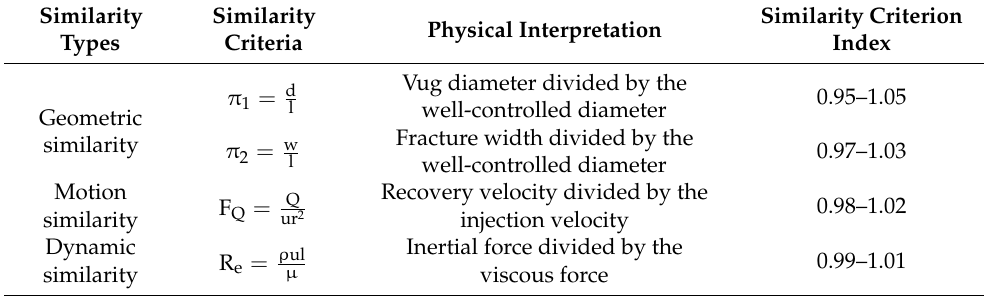
Table 2. Similarity